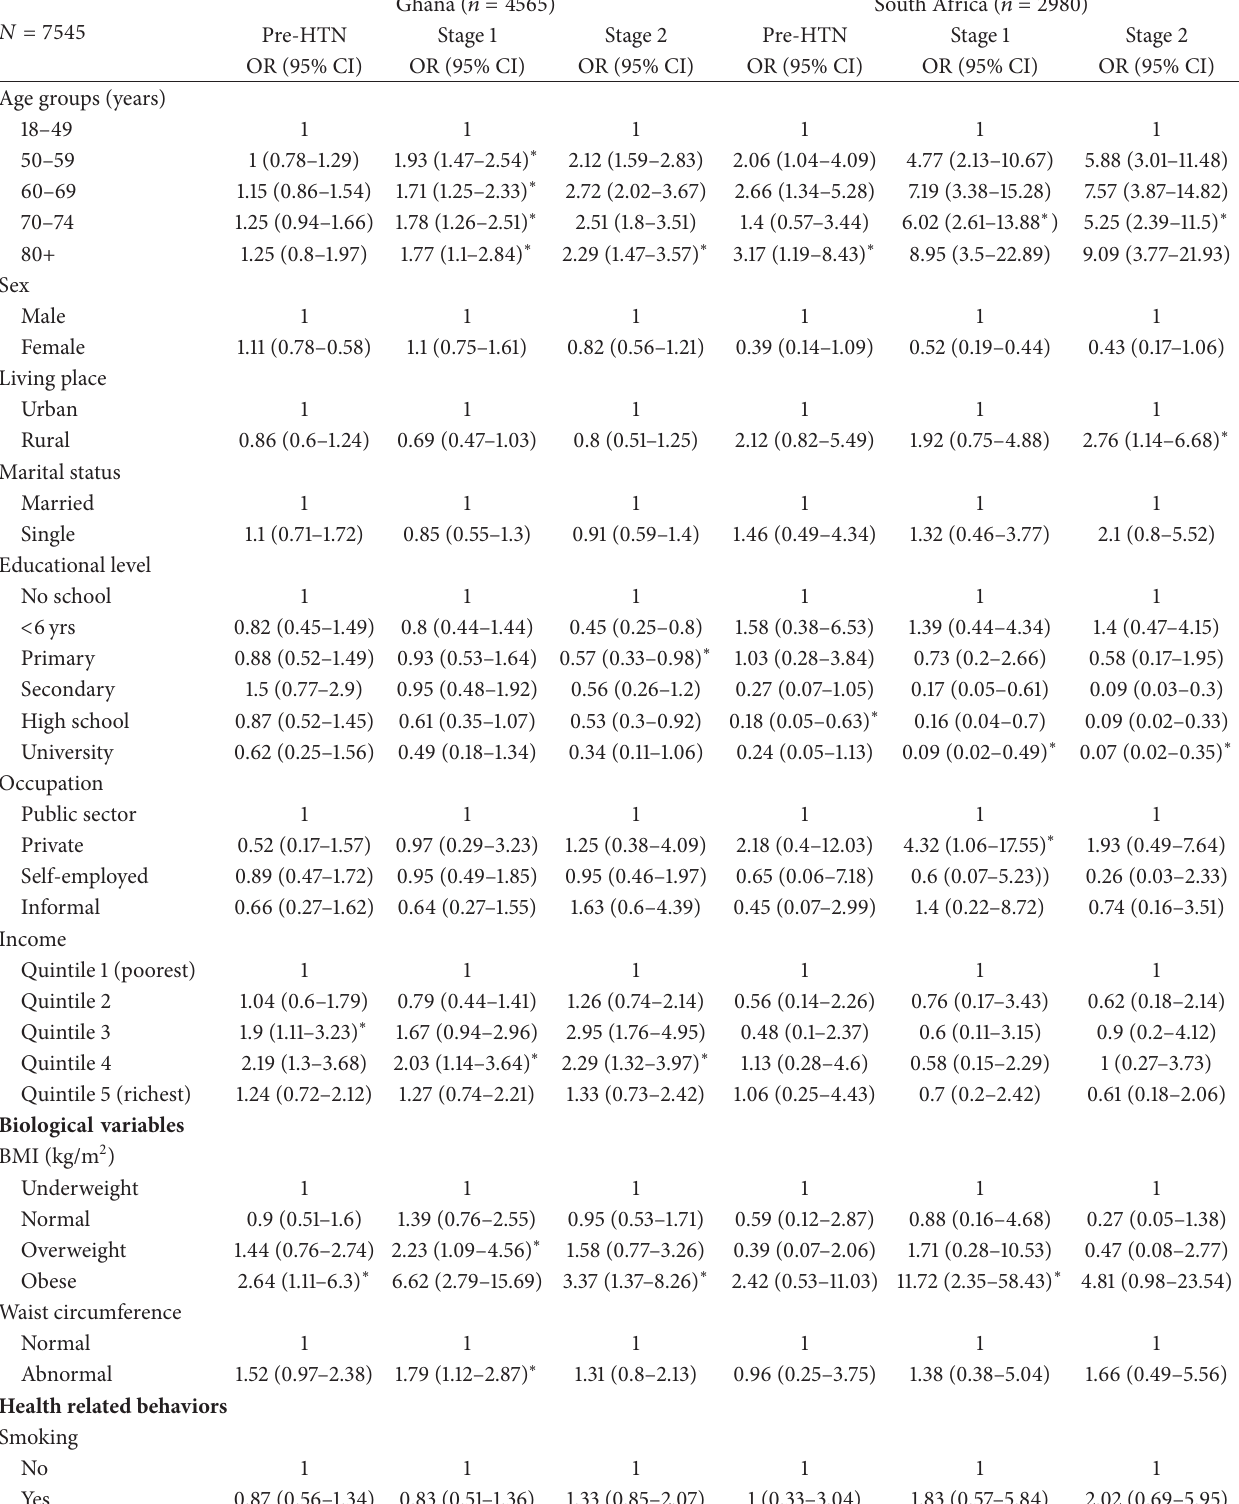
Table 2: Association between sociodemographic, health behavior, and biological variables with stages of hypertension (pre-HTN, stage 1, and stage 2) compared to normal blood pressure: bivariate multinomial